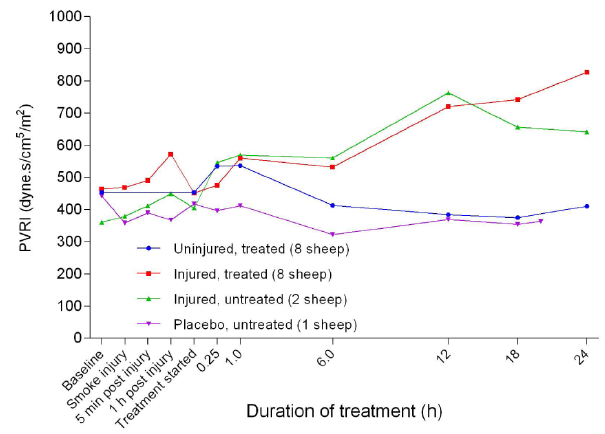
Figure 30. Cardiac index (Mean ± SD error bars not shown) in smoke and non-smoke injured sheep that received extracorporeal life support as compared to that in untreated controls.